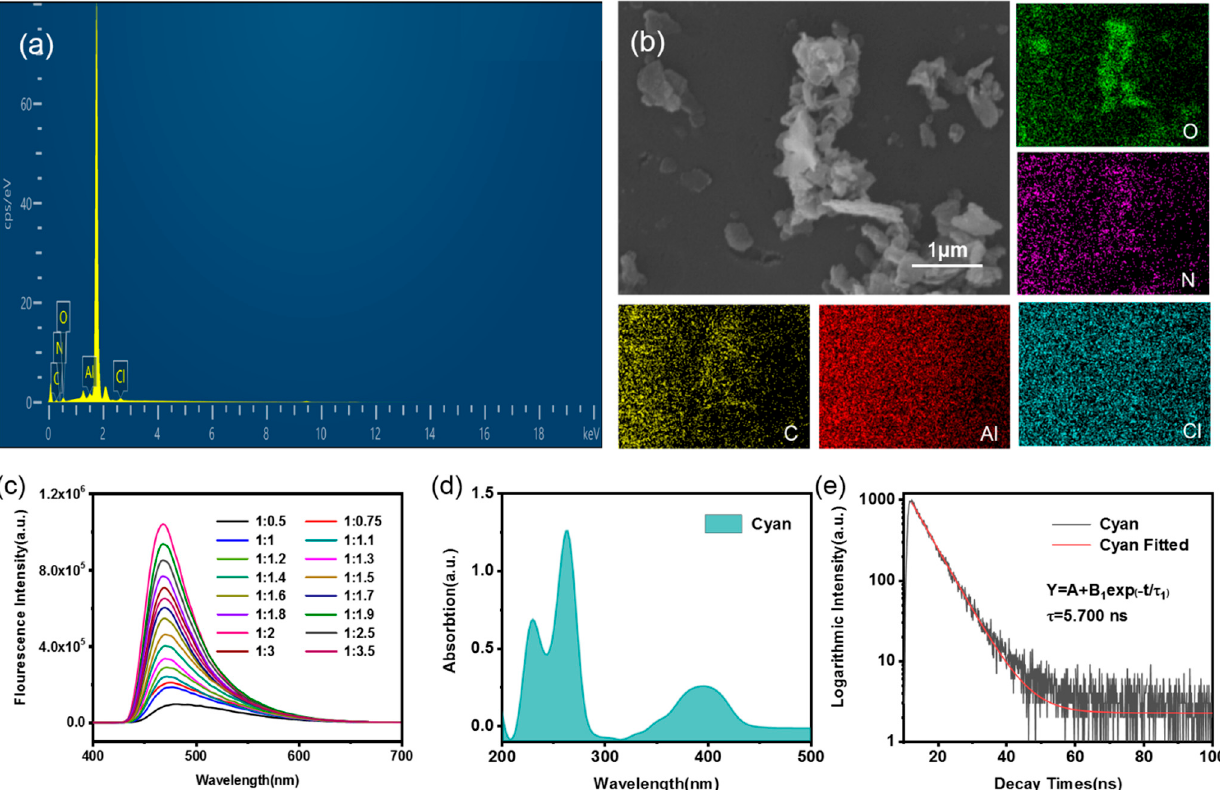
Figure 6. ( a ) EDS spectrum, ( b ) SEM image and EDS elemental mapping of the AHDAs with cyan light, ( c ) emission spectra of the mixture of Al(3-HF) 2 and Al(DCHQ) 3 solutions with varying volume ratios, ( d ) UV–VIS absorption spectrum of CLS, and ( e ) fitting time-resolved fluorescence decay curve of CLS.